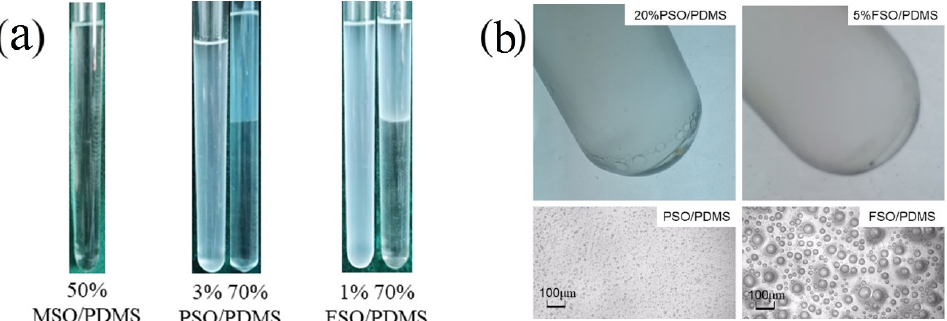
Figure 3. Morphology of different silicone oil/PDMS mixtures: ( a ) macroscopic images; ( b ) OM images. The silicone oil droplets changed when increasing silicone oil’s concentration in PDMS, which is shown, respectively, for PSO/PDMS and FSO/PDMS mixtures in Figure 4 and Figure 5. The immiscible silicone oil droplets can be seen clearly in the blend solu- tion under the microscope. Furthermore, the size of the droplets became larger after in- creasing the concentration of silicone oil. The size of FSO droplets was larger than that of PSO droplets, due to the weaker compatibility of FSO with PDMS.